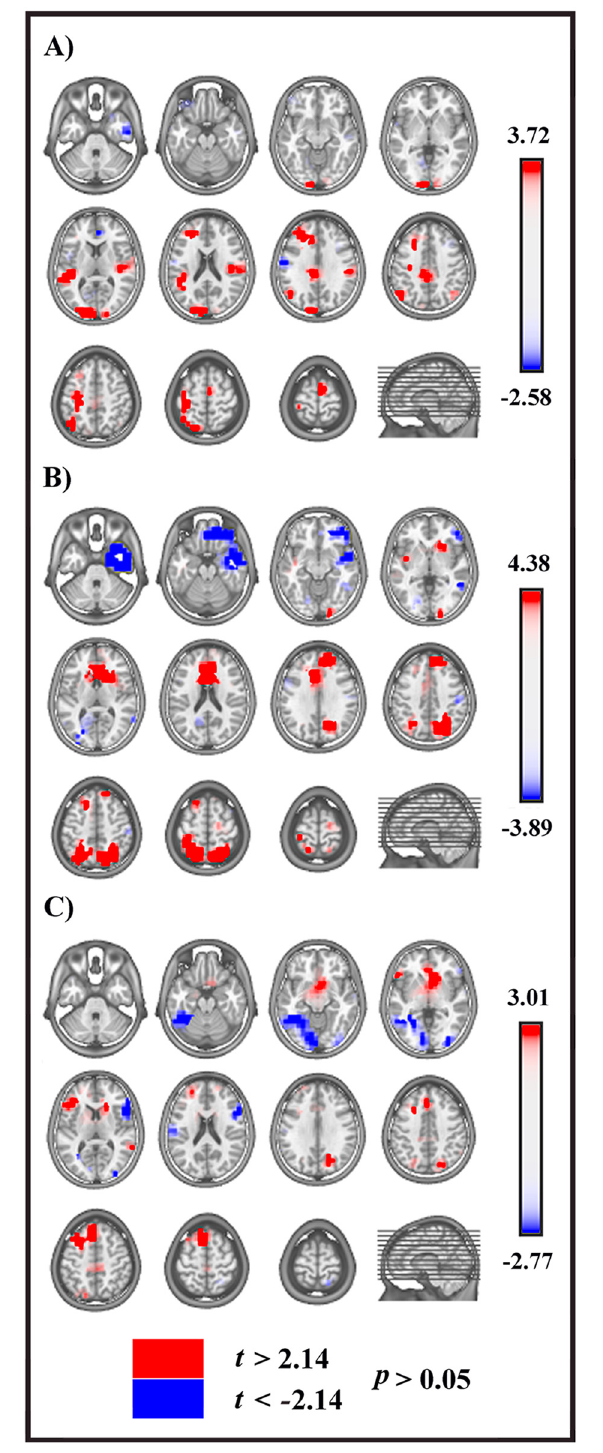
Fig 4. Statistical comparisons of LAURA source estimations between session A and B over significant TANOVA time intervals. All significant voxels are colored ( t (14) > 2.14 / < -2.14, p < .05): positive t values (red color) indicate higher current source densities in session A than in session B; negative t values (blue color) indicate higher current source densities in session B than in session A. LAURA solutions are rendered on MNI152 template brain (left hemisphere on the left side). (A) First significant TANOVA time